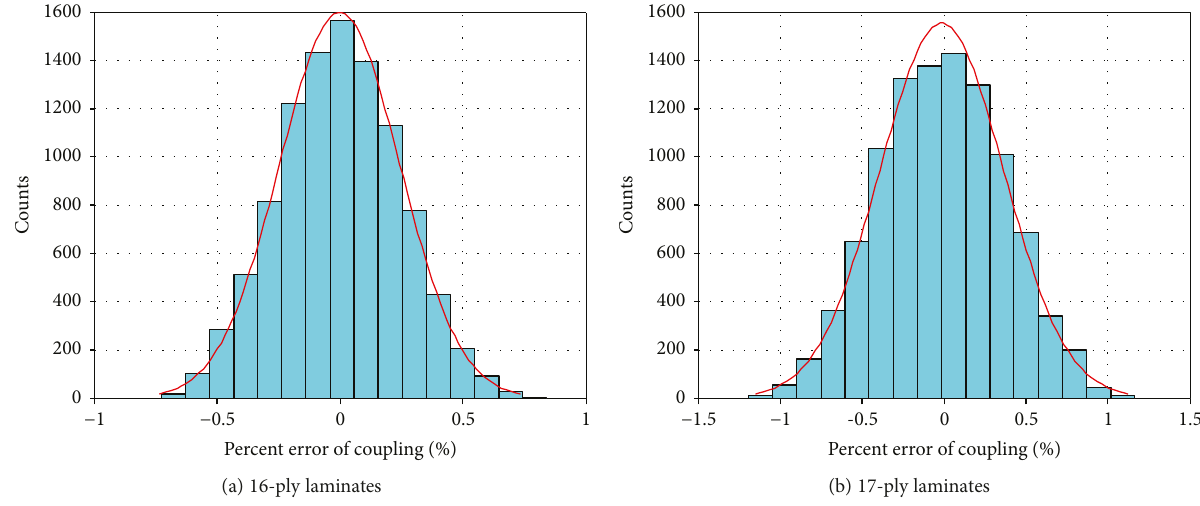
B D F 0 S laminates on extension-shear